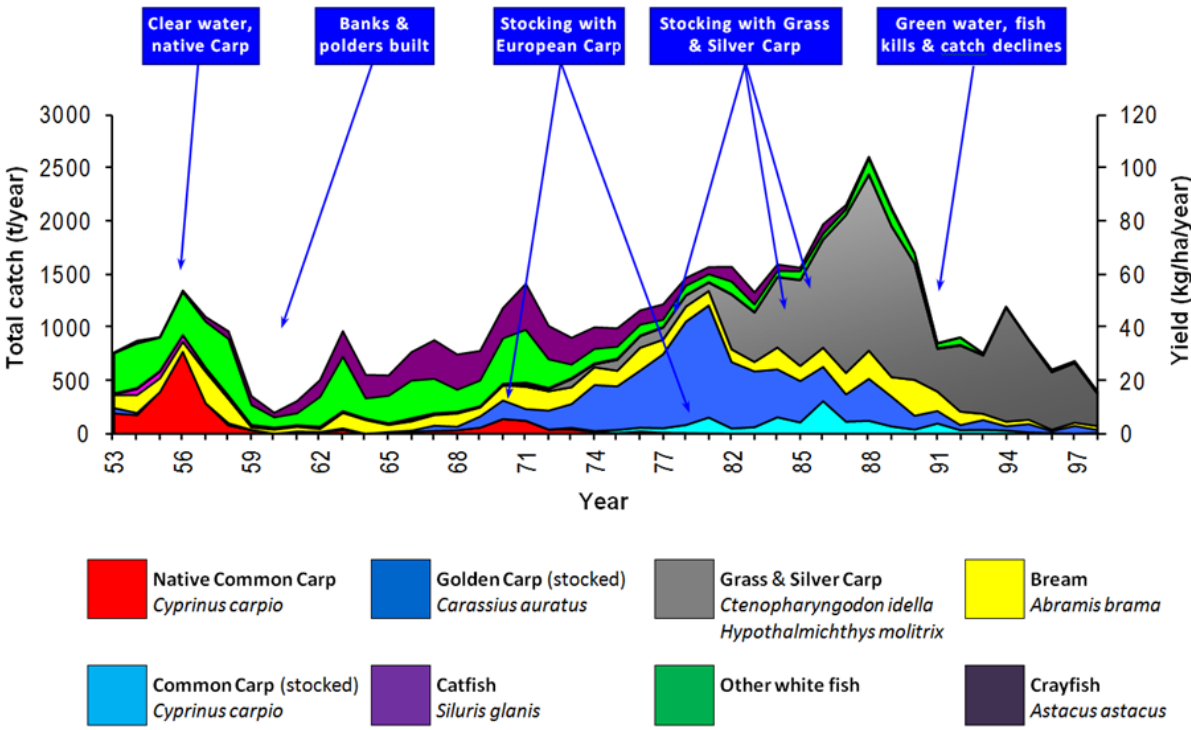
Figure 2: Composition of total fish catches and yield in Lakes Yalpug, Kugurlui and Katlabugh from 1953 to 1997, related to main impacts and development of stocking. Adapted from Goriup & Goriup (2015) based on data from Odessa Fisheries Protection Department in de Graaf et al .